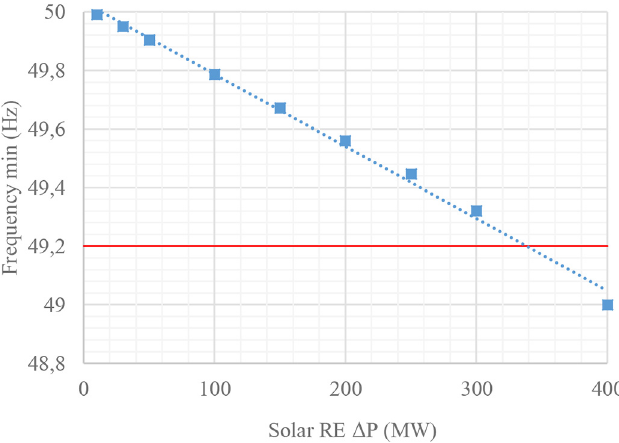
Fig. 7. Frequency dip as a function of the variable solar RE magnitude drop with